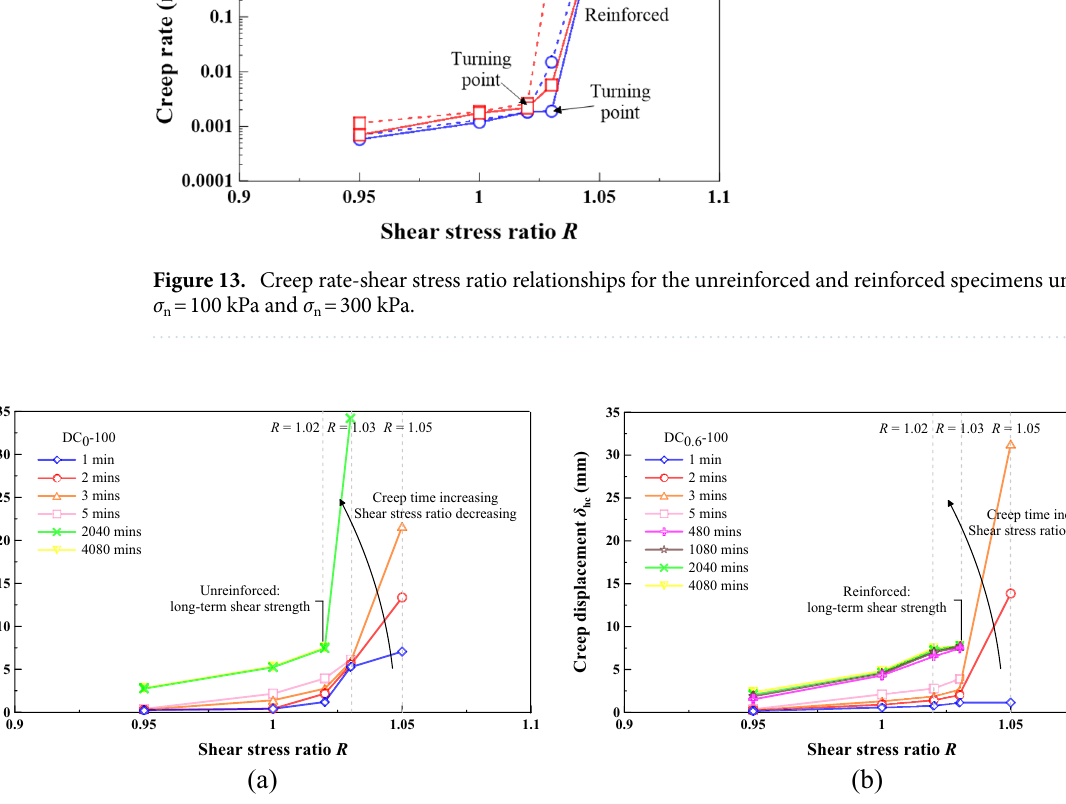
Figure 14. Isochronal curve for ( a ) unreinforced specimen under σ n = 100 kPa and ( b ) reinforced specimen under σ n = 100